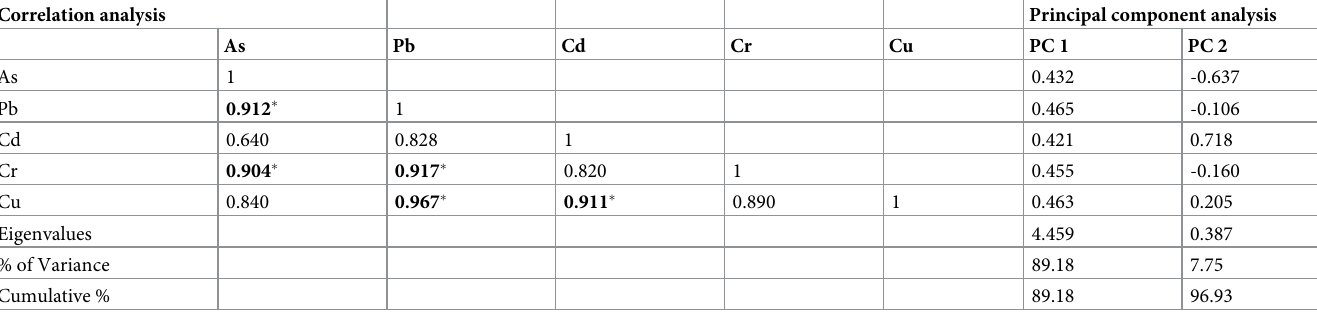
Table 3. Pearson’s correlation coefficient between heavy metal elements and matrix of PCA loadings. Correlation analysis